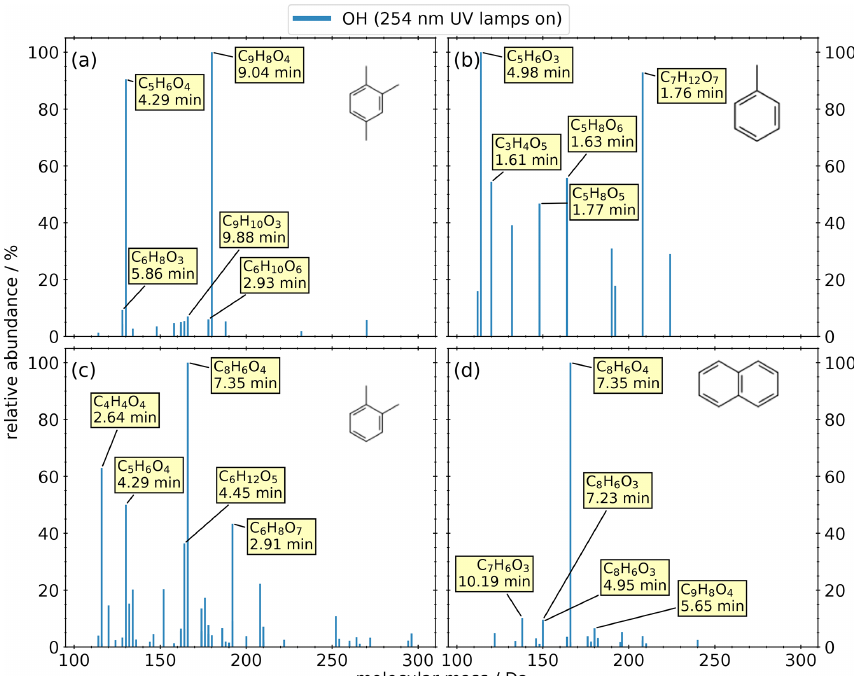
Figure 3. Mass spectra of detected products from OFR experiments of four anthropogenic precursors: (a) 1,2,4-trimethylbenzene, (b) toluene, (c) o -xylene, (d) and naphthalene. The intensity is normalized to the highest signal of each chemical system. The most abundant compounds of each experiment are labeled with their predicted composition and the according retention